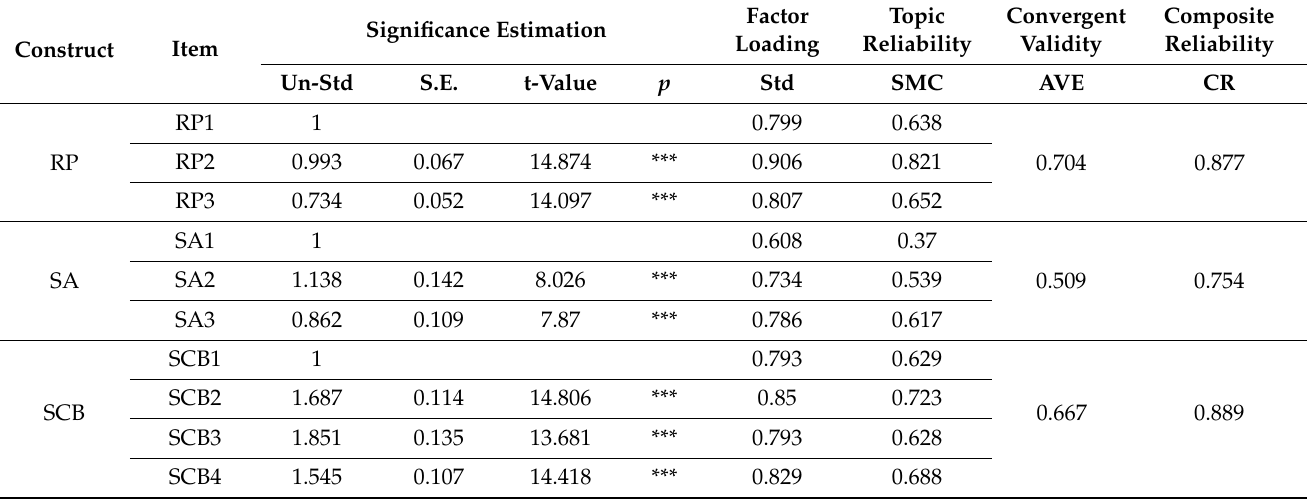
Table 5. Parameter significance estimation and convergence validity of the measurement model.